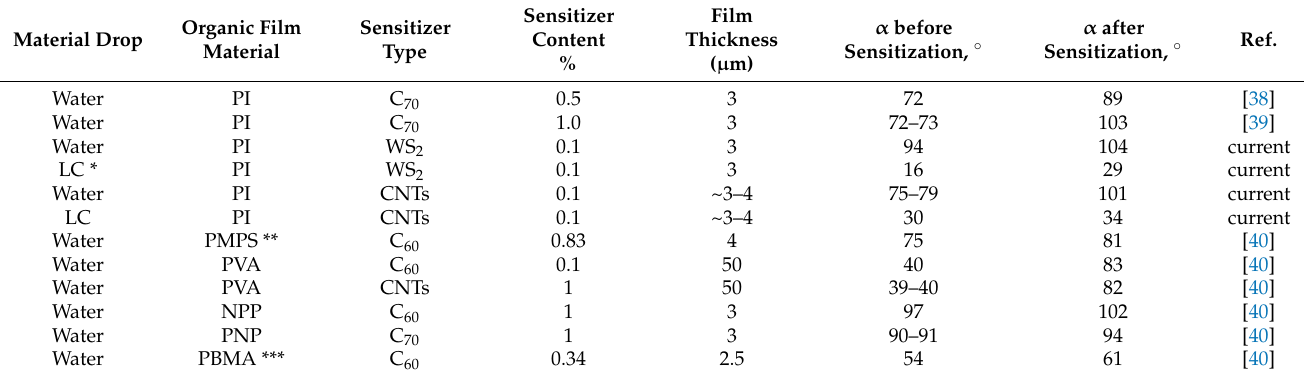
Table 1. Variation of the wetting angle α with the nanoparticles added for the currently studied surfaces in comparison with different organic thin films used previously for this